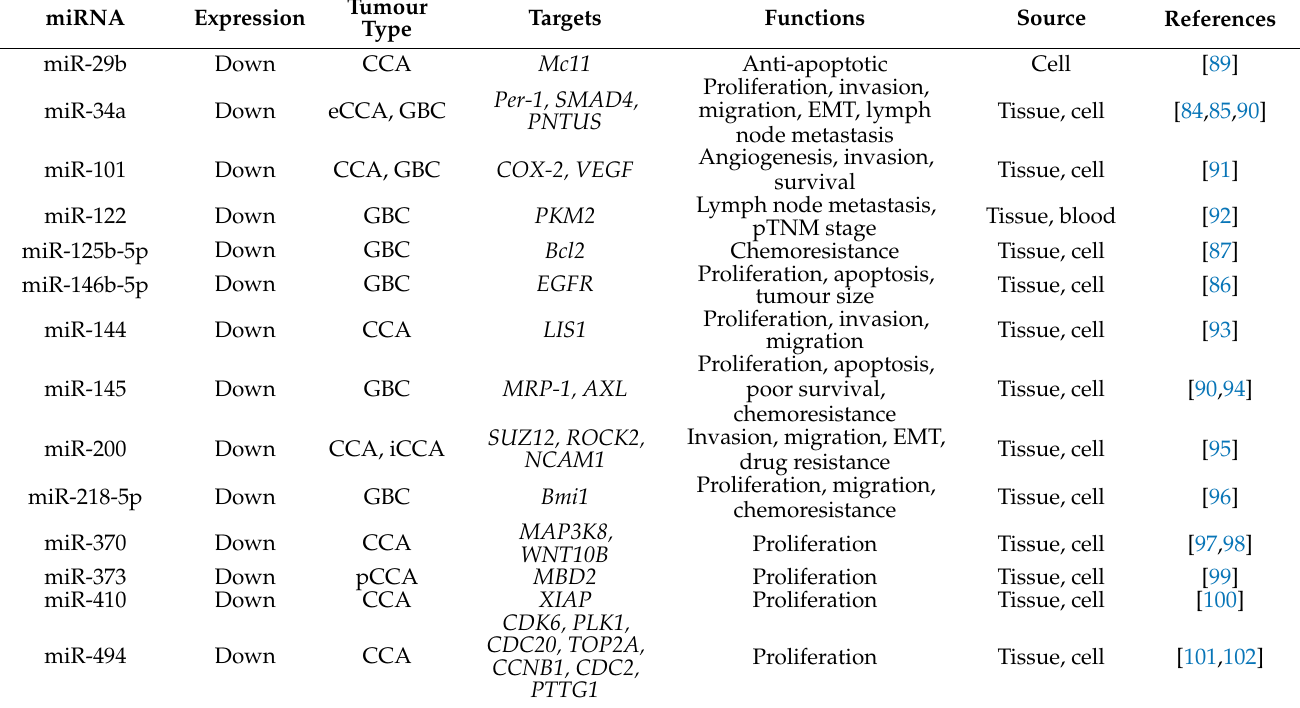
Table 2. Tumour suppressor miRNA and their role in biliary tract